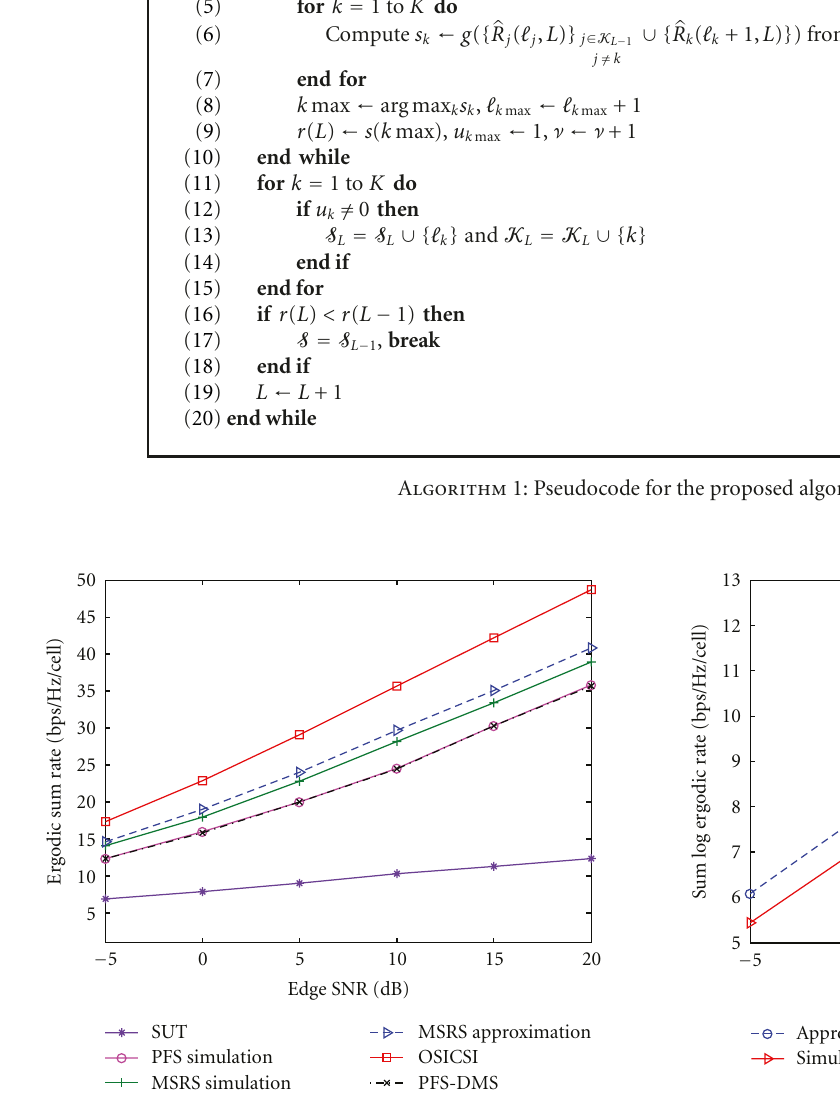
Figure 5: Comparison of sum log ergodic rate versus edge SNR for B = 3, K = 30, N t = 4, and N r =